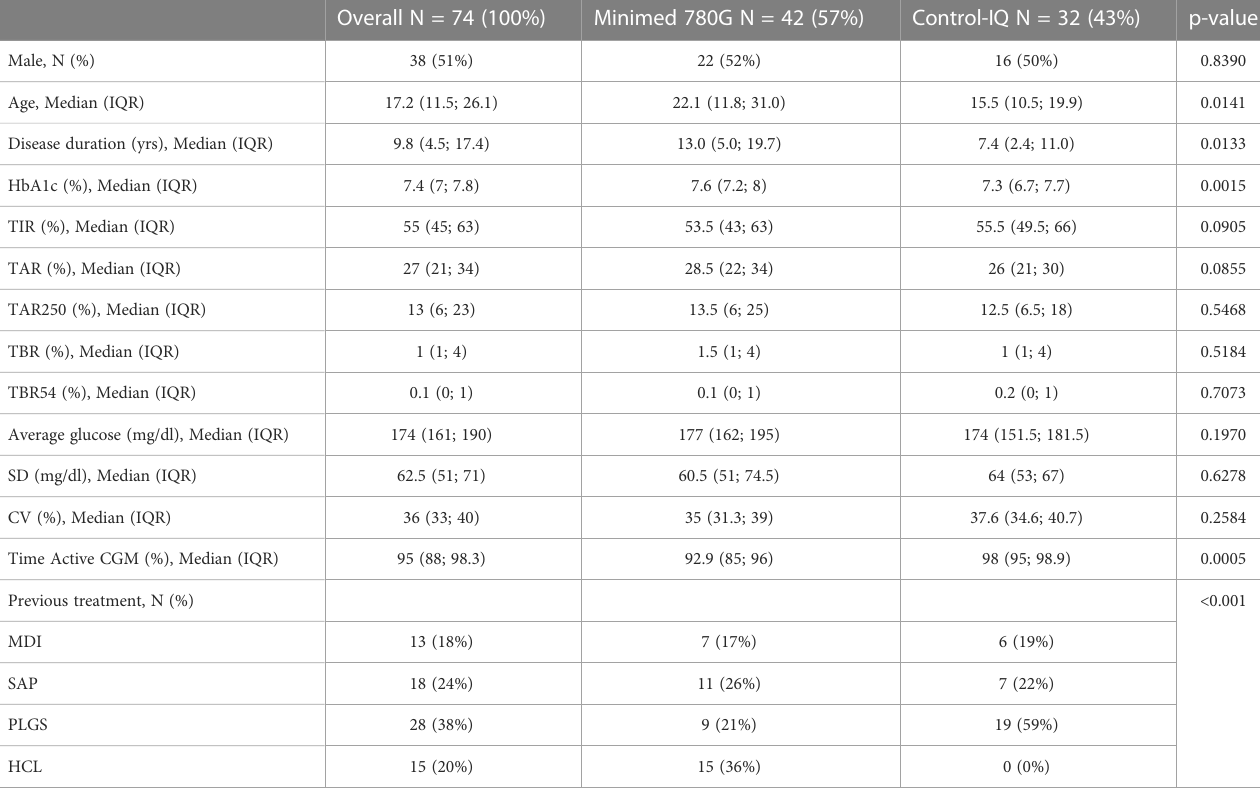
TABLE 1 Patient characteristics at baseline (T0), overall and by treatment